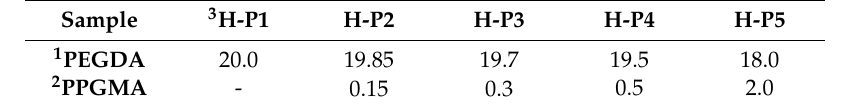
Table 2. Composition of the hydrophobically-modified hydrogel to evaluate the protein release rate. Sample